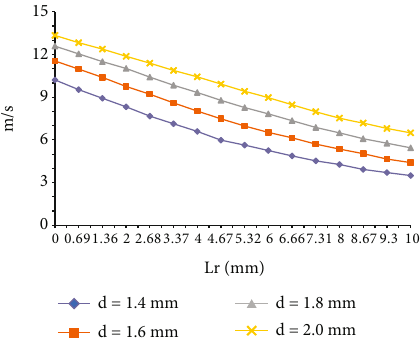
Figure 11: Pressure distribution of the water jet on the central